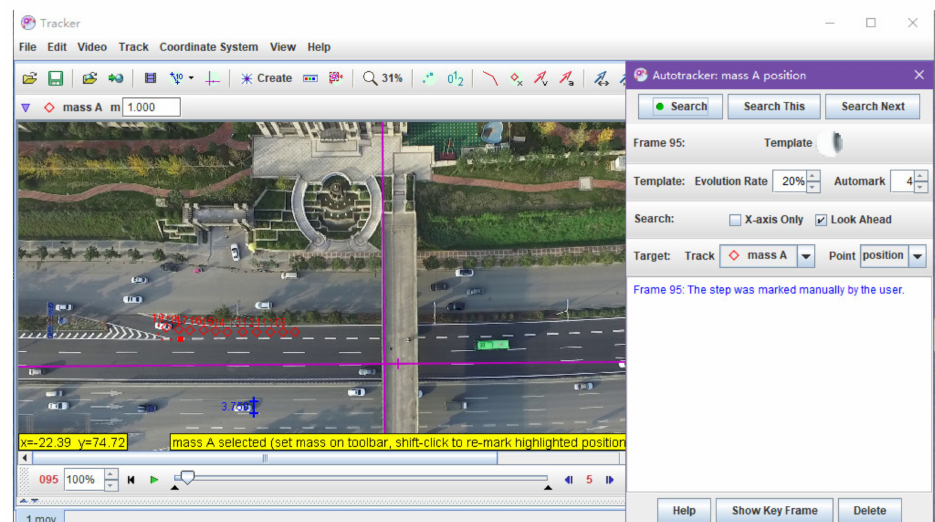
Figure 2. Coordinate calibration.